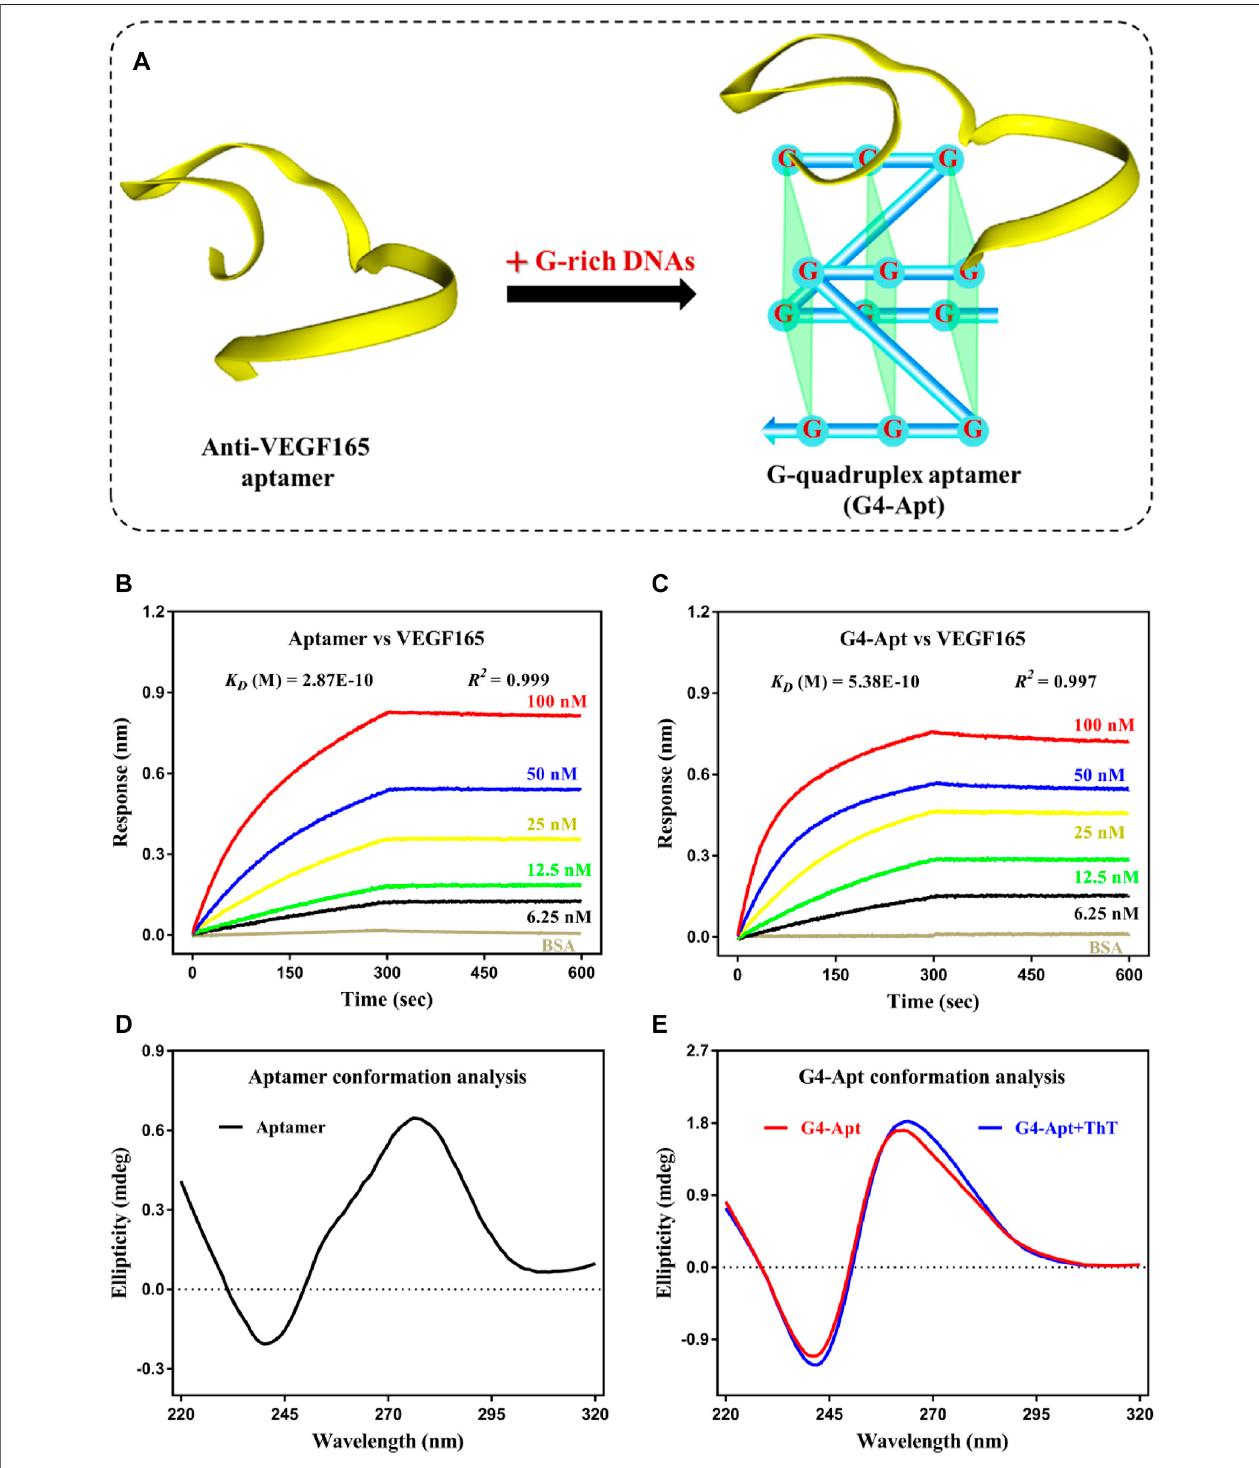
FIGURE 1 | (A) Schematic diagram of the construction of the G-quadruplex aptamer. (B,C) Af fi nity and speci fi city analysis of the anti-VEGF165 aptamer and the assembled G4-Apt by biolayer interferometry. (D,E) Conformation analysis of the anti-VEGF165 aptamer and the assembled G4-Apt by circular dichroism.